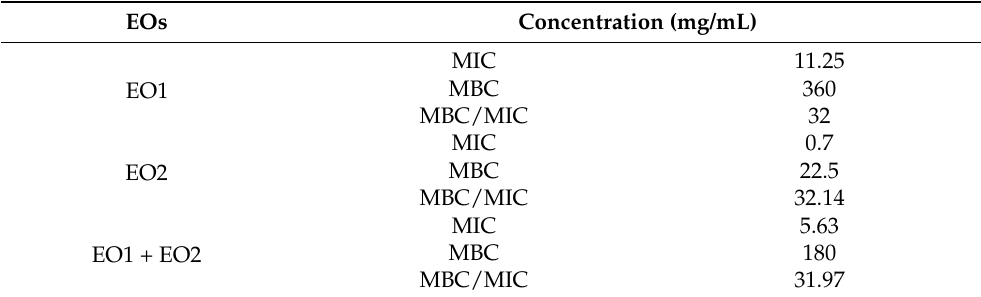
Table 2. Antibacterial activity of R . officinalis (EO1) and M. communis (EO2) essential oils and their combination (EO1 + EO2) against S. aureus ATCC 25923.